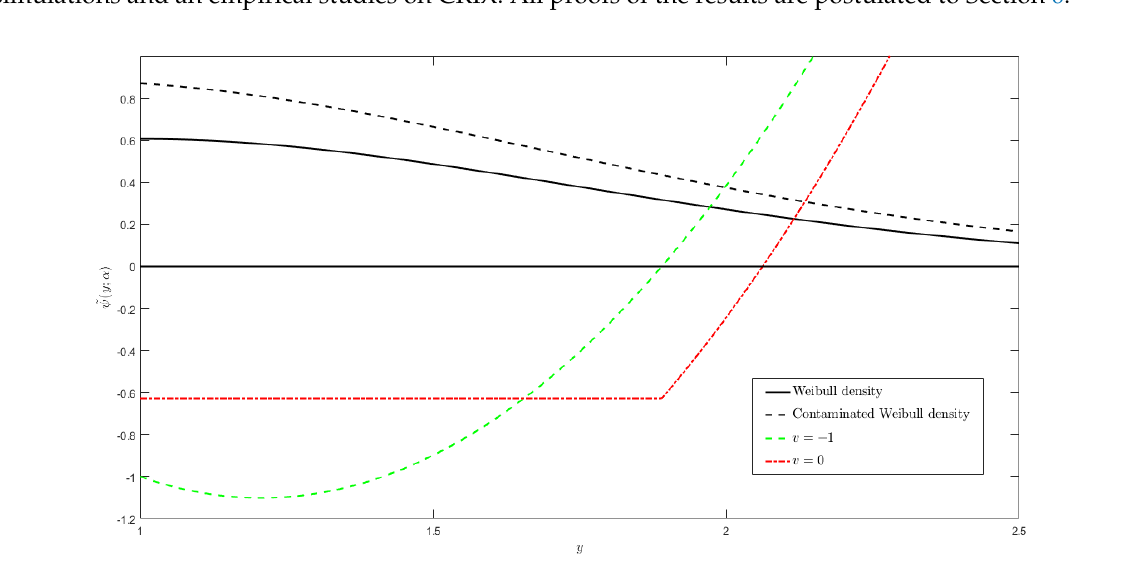
Figure 1. Psi-functions ˜ ψ for the huberized M -estimators ˜ T are generated from the Weibull F W ( x ; α ) and contaminated Weibull F (cid:101) ( x ) = ( 1 − (cid:101) ) F W ( x ; α ) + (cid:101) Γ ( x ; λ , β ) with α = 2, c 0 = 0.5, (cid:101) = 0.3, λ = 1, β =